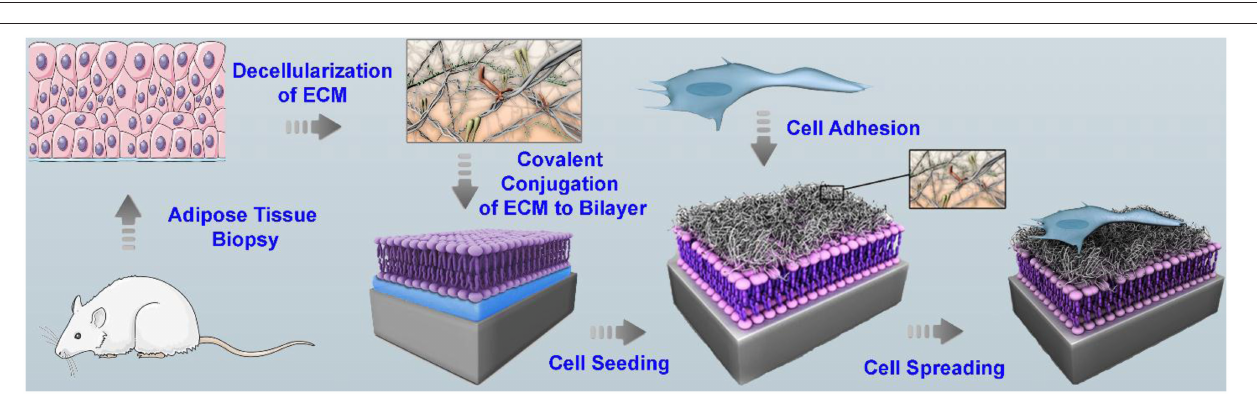
FIGURE 2 | Fabrication processes of functionalized PSo- (A,C,E) and SLB-based (B,D,F) protein adsorbed films for investigating responses of NIH-3T3 fibroblasts. In serum-free culture medium, cells were incubated on six types of surfaces for 6 h. Reprinted with permission from Huang et al. (2010c) Copyright 2010 Elsevier Ltd.